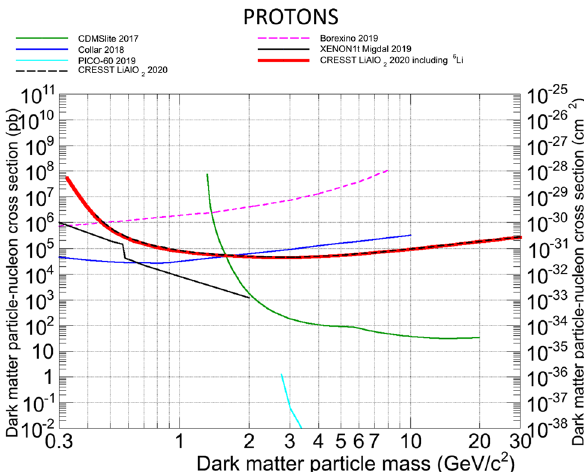
Fig. 1 Exclusion limits set by various direct detection experiments for spin-dependent interactions of dark matter particles with protons.The result obtained from module B data with 7 Li + 27 Al is shown with a dashed black line [9]. The new result obtained with 6 Li + 7 Li + 27 Al is shown with a solid red line. Additionally, limits from other experi- ments are also shown: CDMSlite with 73 Ge [24]; PICO with 19 F [25]; XENON1T (Migdal effect) with 129 Xe + 131 Xe [26]; J. I. Collar with 1 H [27]. Finally, a constraint from Borexino data derived in [28] is shown in